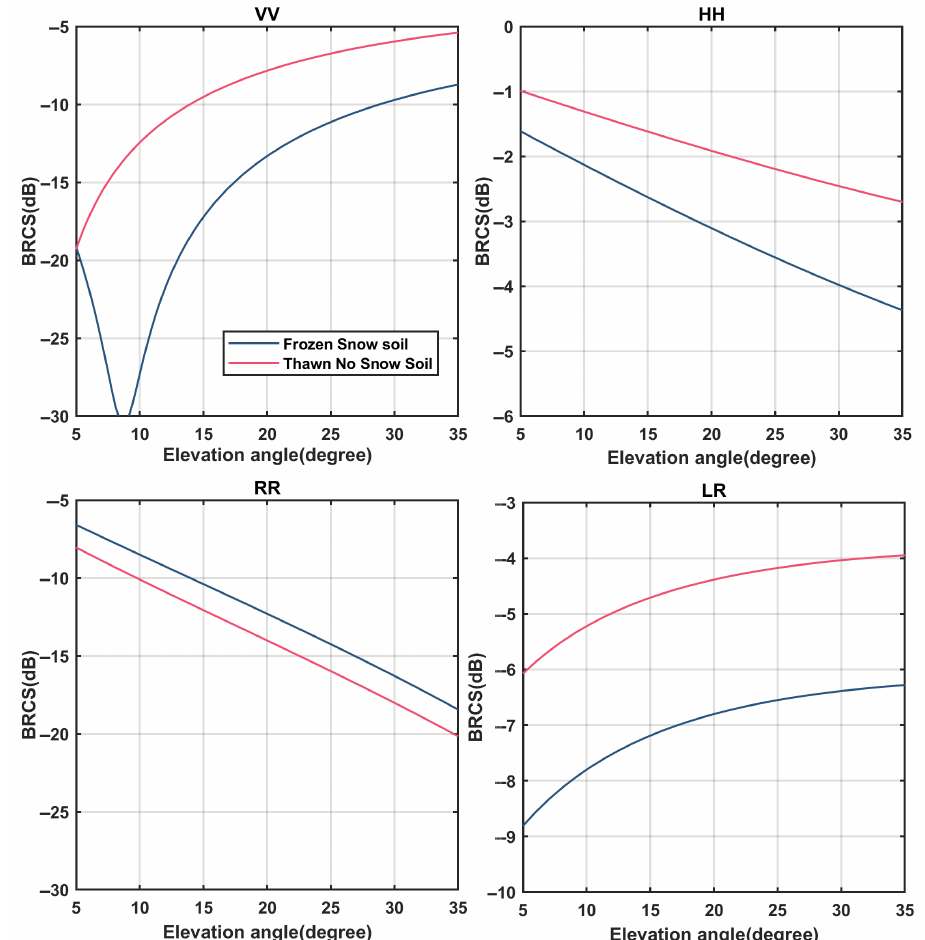
Figure 9. Corresponding changes in BRCS when there is snow cover on the frozen surface and no snow cover on the melting surface under various polarizations. Figure 10 simulates the changes in GNSS multipath observations and effective reflec- tometer height when the frozen surface is covered with snow and the melted surface is not covered with snow. From the simulation in the figure, it can be seen that when the frozen surface is covered with snow, due to the change of the water phase and the attenuation of the snow layer, the BRCS will be reduced (Figure 9), so the corresponding amplitudes of GNSS multipath observation and effective reflectometer height